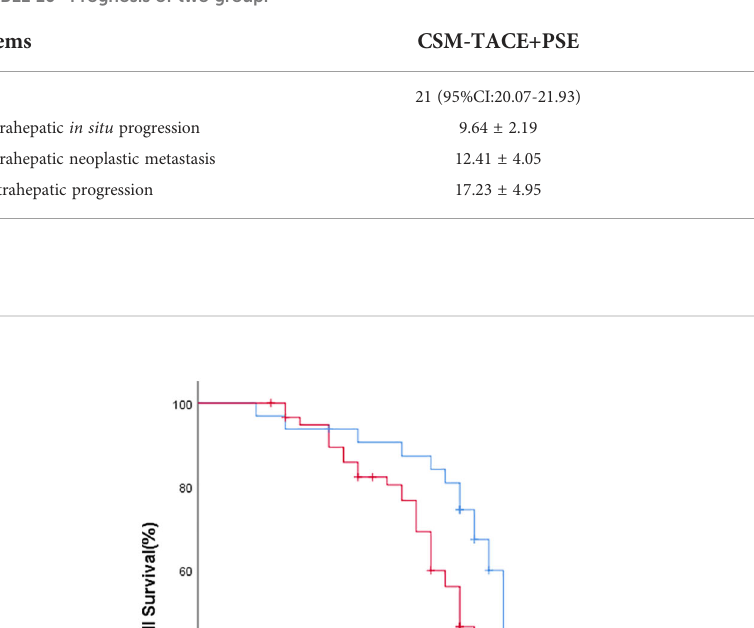
TABLE 10 Prognosis of two group.